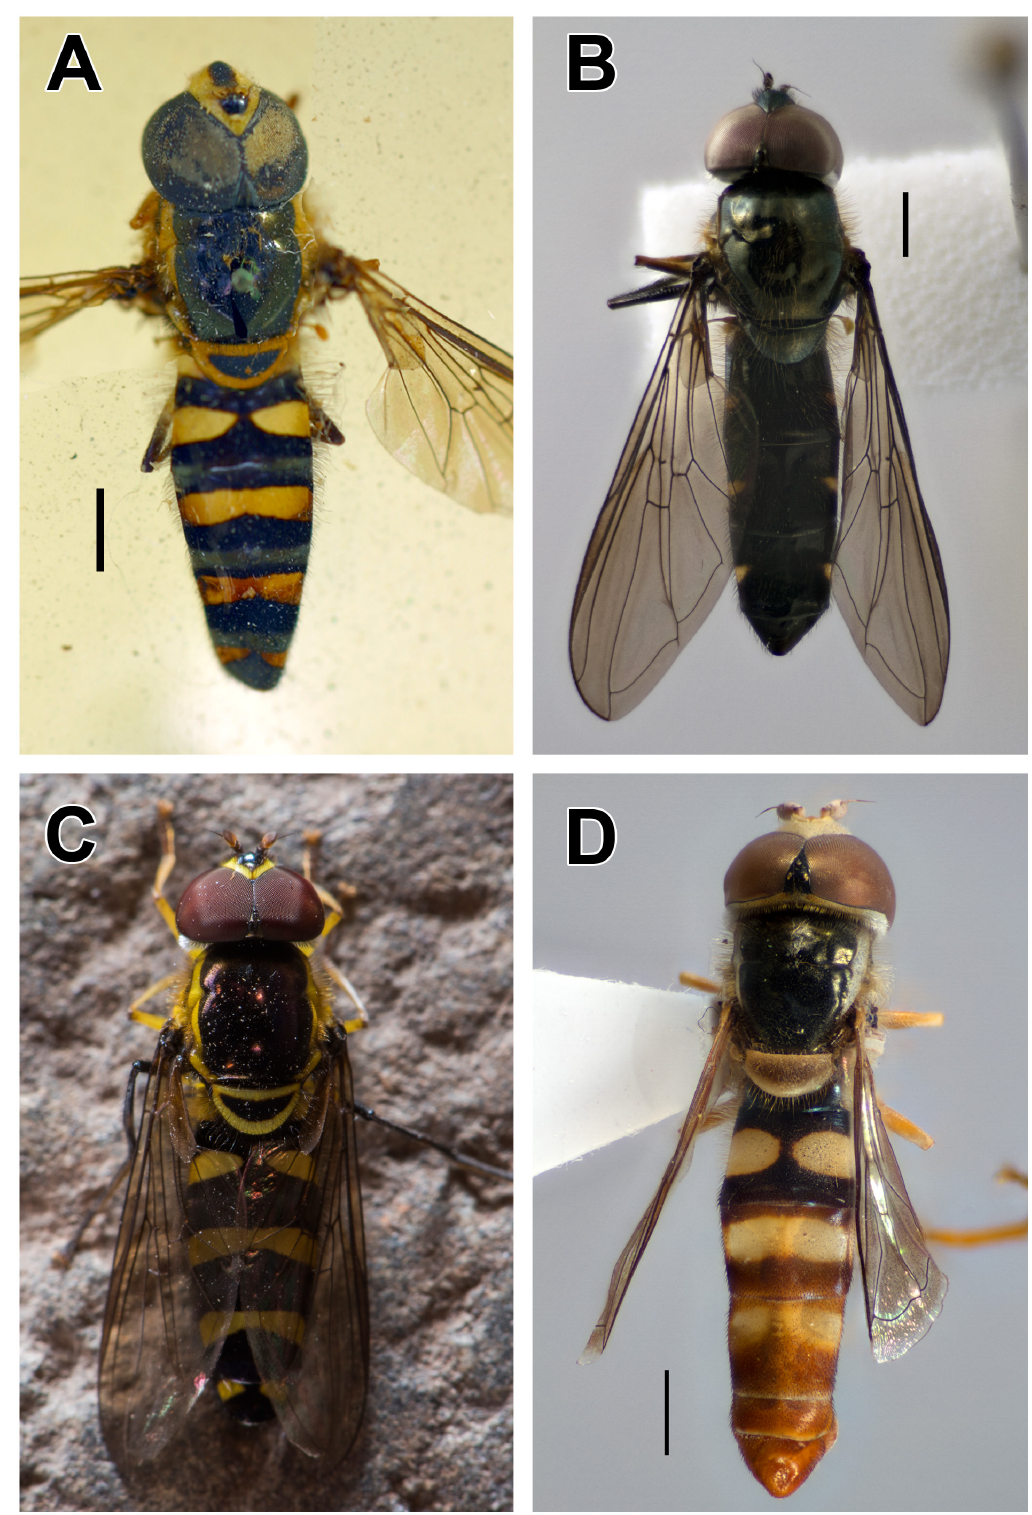
Fig. 2. A . Allograpta amphotera (Bezzi, 1928), holotype, ♂, dorsal view. B . Allograpta jacqui Mengual & Ramage sp. nov., holotype, ♂ (ZFMK-DIP-00019707), dorsal view. C . Allograpta nigripilosa (Hull, 1944), ♂, dorsal view (photograph by F. Jacq). D . Ischiodon scutellaris (Fabricius, 1805), ♂ (ZFMK- DIP-00019713), dorsal view. Scale bars = 1